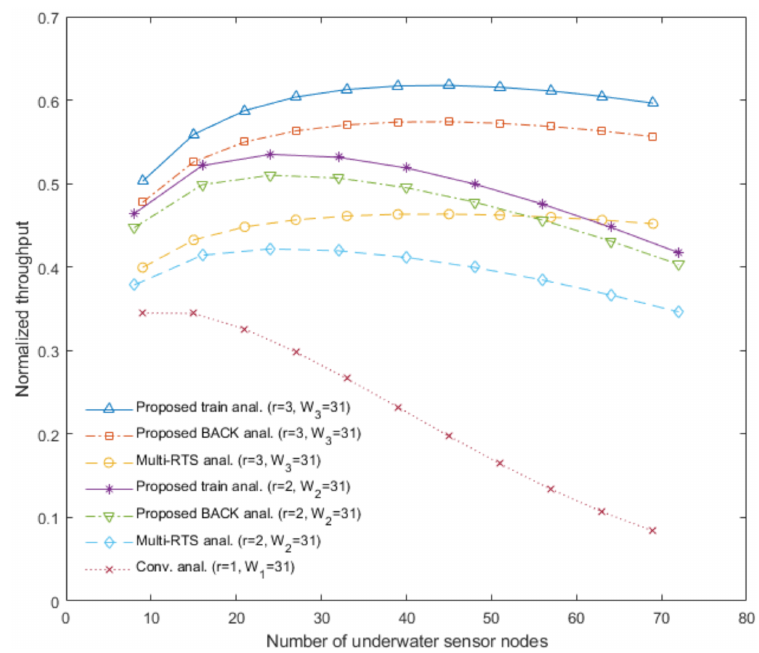
Figure 9. Normalized throughput versus the number of underwater sensor nodes for the proposed underwater multi-DATA train protocol, the proposed underwater BACK protocol, the underwater multi-RTS reception protocol, and the conventional CSMA / CA